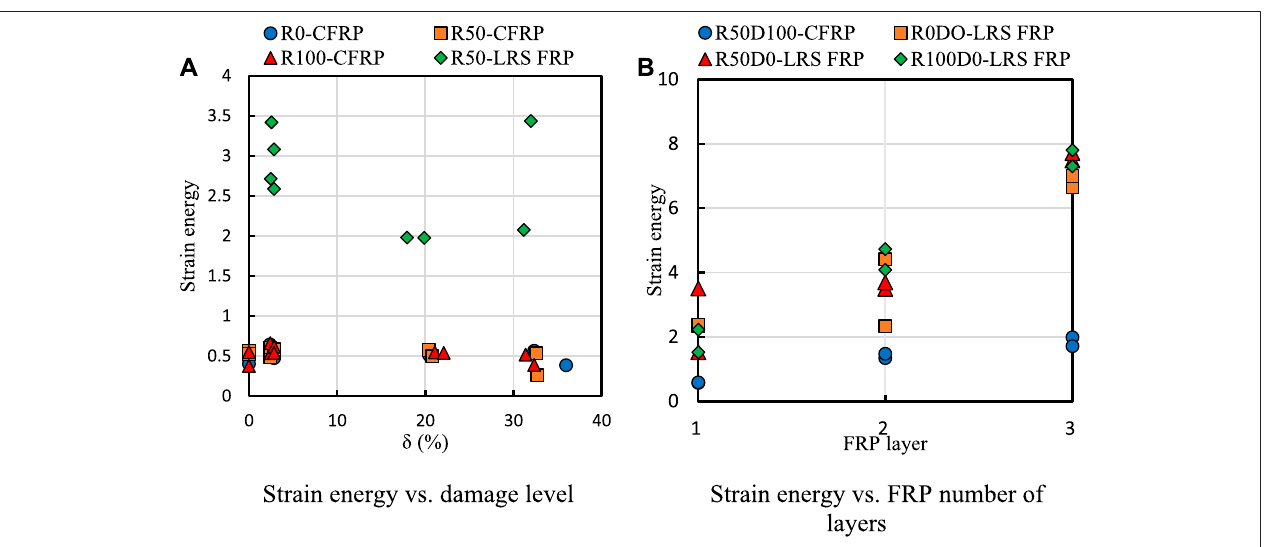
Figure 17 | Effect of damage level and FRP layers on strain